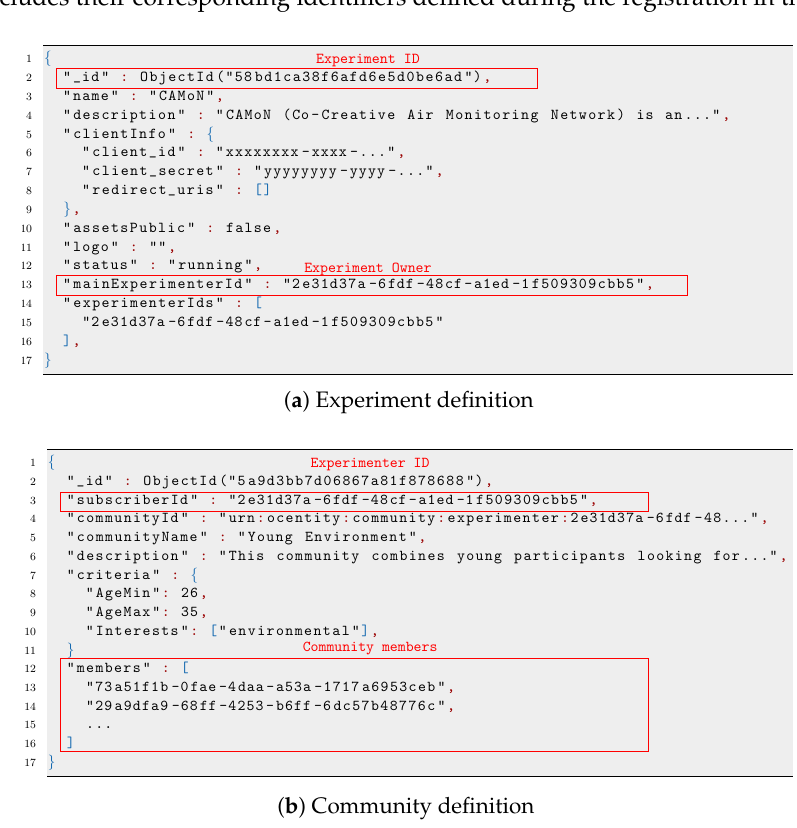
Figure 3. Illustrative example of experiment and communities defined during an experiment. In both cases, relevant identifiers are